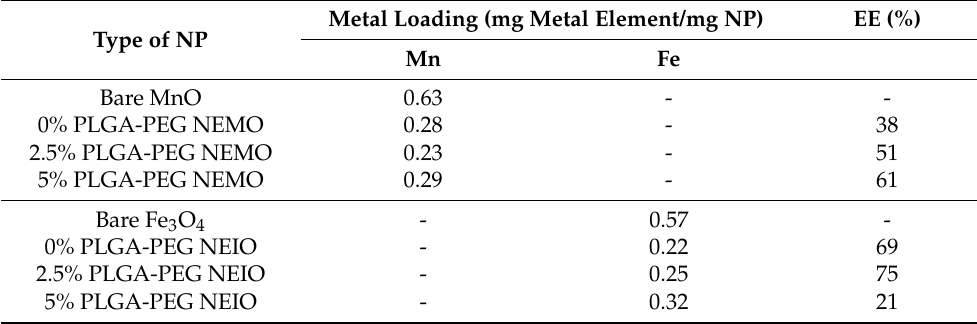
Table 2. Metal loading and EE percentage for each type of NP based on ICP-OES analysis. Metal Loading (mg Metal Element/mg NP) EE (%) Type of NP Mn Fe Bare MnO 0.63 -